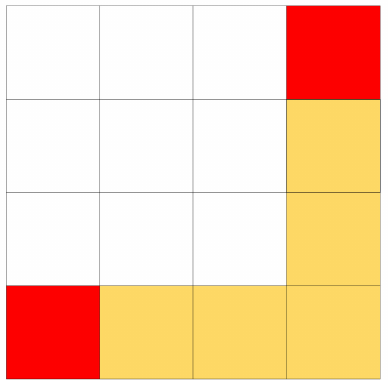
Figure 7. Two-dimensional space grid